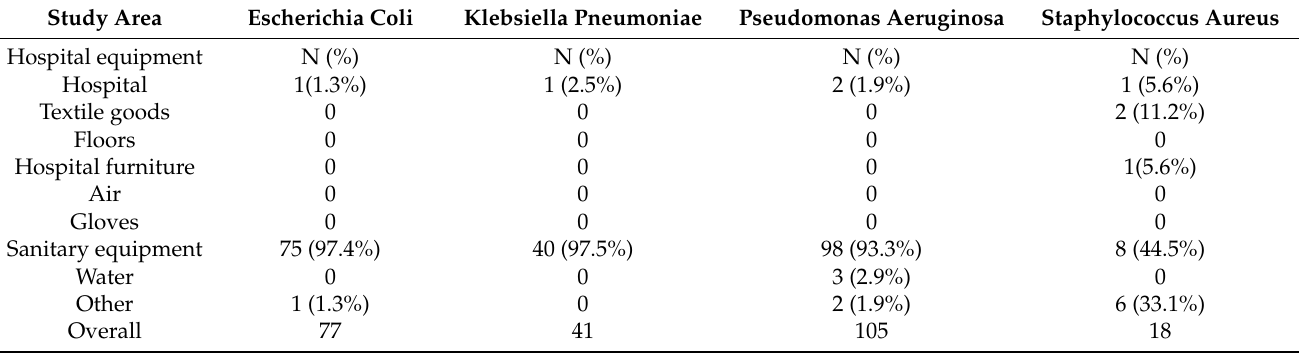
Table 7. Pathogenic microorganisms isolated during the entire study period 1